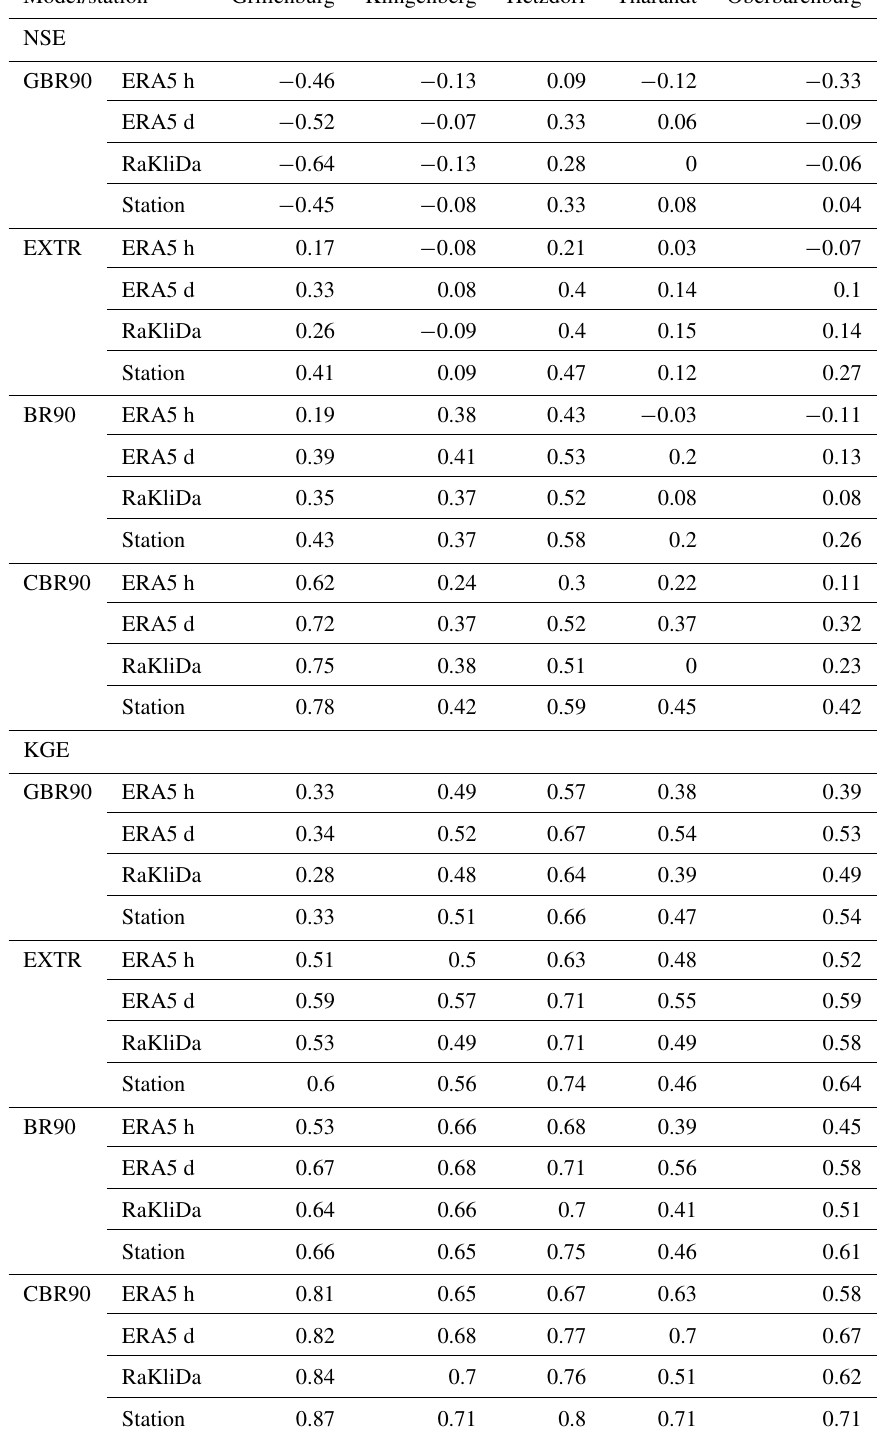
Table E2. Daily evaporation skill scores for the vegetation period. Model/station Grillenburg Klingenberg Hetzdorf Tharandt